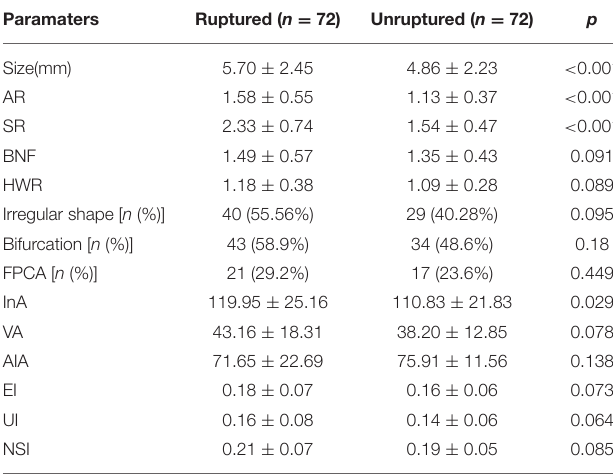
TABLE 2 | Result of univariate statistical analysis for morphological